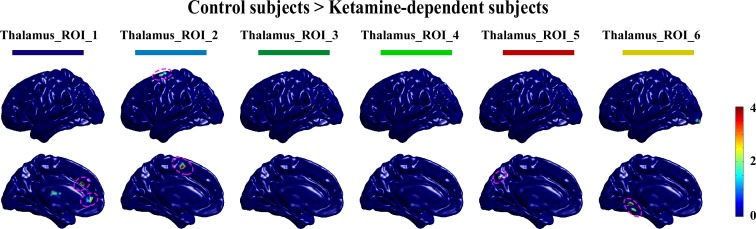
Differences of functional connectivity patterns of thalamus ROIs between drug-free control subject group and ketamine user group.The purple dotted lines show the significant different brain regions (single voxel P<0.01, cluster size>20 voxels).